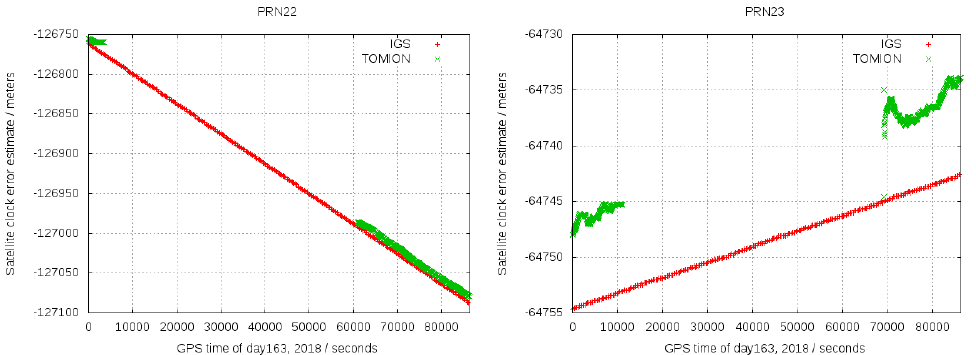
Figure 2. GPS clock errors for PRN22 ( left ) and PRN23 ( right ) from WARTK TOMION (green) and IGS (red).